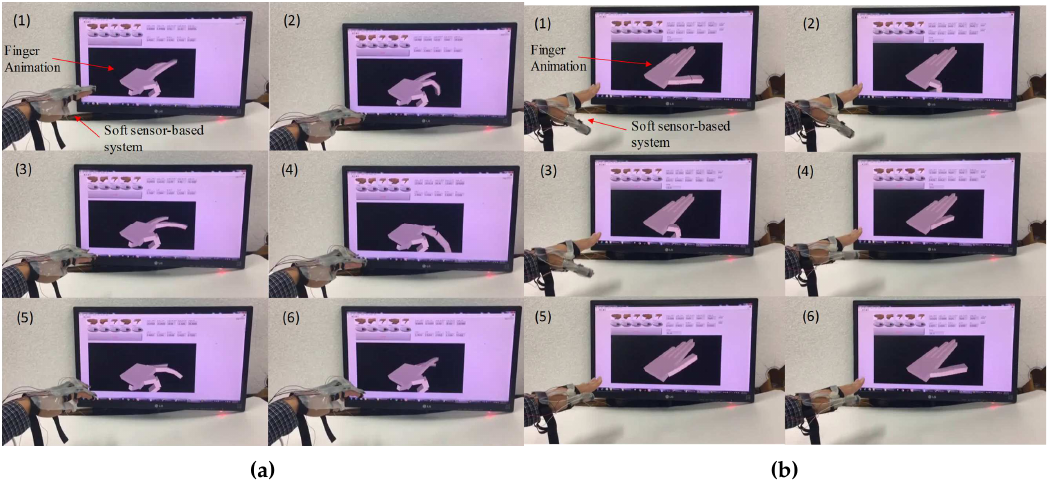
Figure 16. Finger animation by the measured 3-D finger joint angles: ( a ) Measured 3-D motion of the index; ( b ) Measured 3-D motion of the